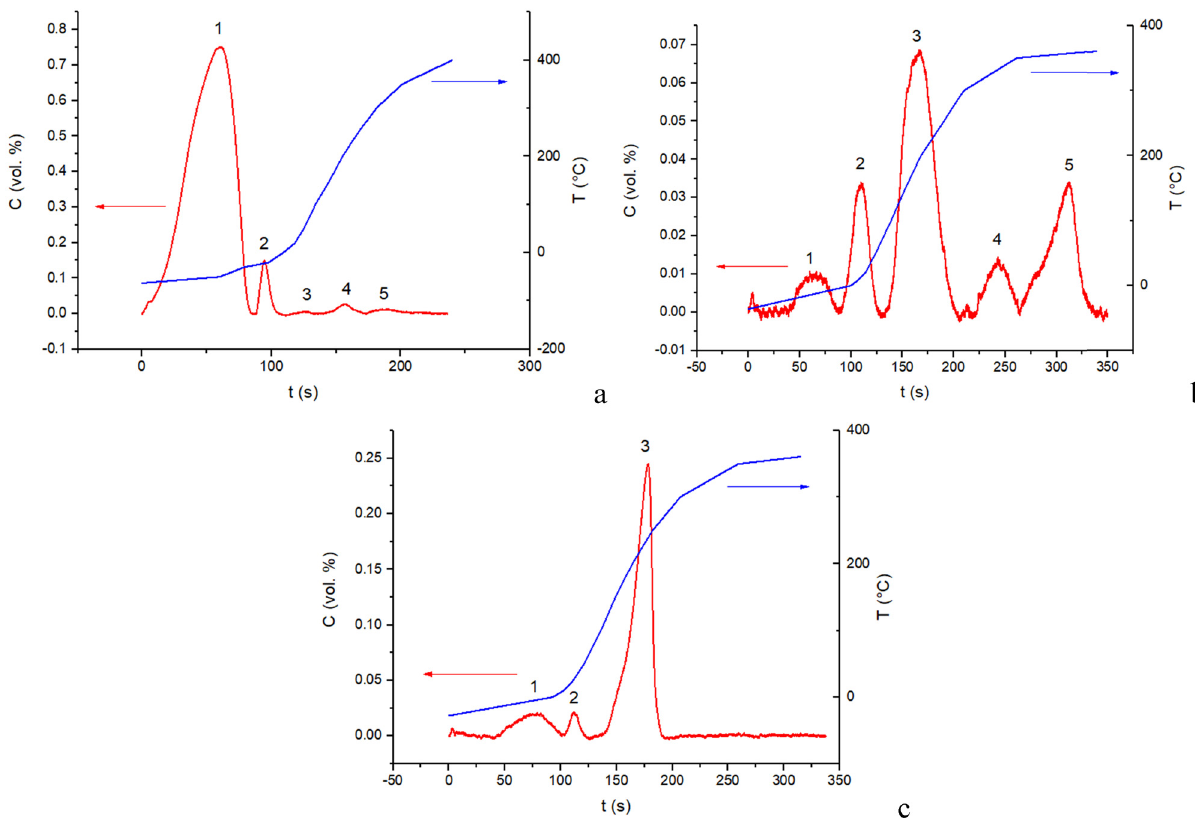
Figure 4: Temperature - programmed CO desorption from the surface of Sim1 ( a ) , Sim2 ( b ) and Sim3 ( c ) nanocomposites. Red line – CO concentration ( left axis ) , blue line – temperature ( right axis ) .